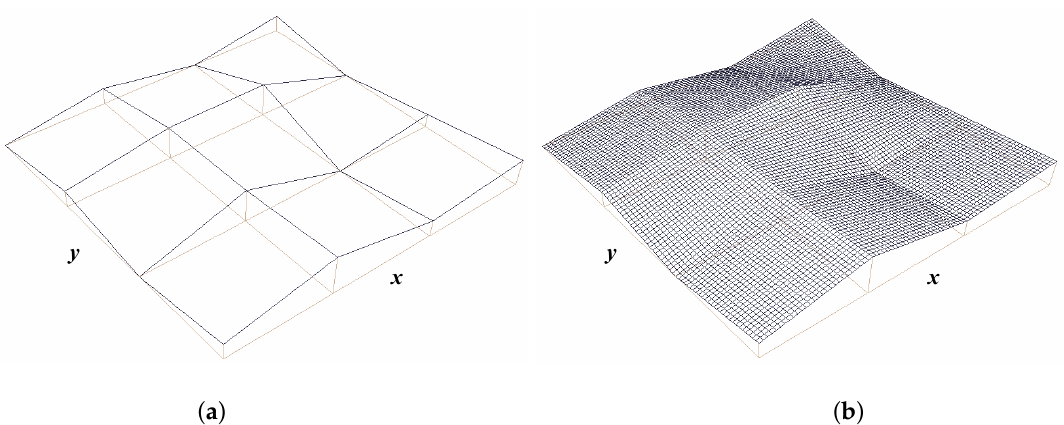
Figure 4. ( a ) The surface constructed with the original set of data. ( b ) The (fractal) interpolation surface. ( β ) All interpolating nodes of the sides AB, B Γ , Γ∆ and ∆ A of Figure 1 are collinear.